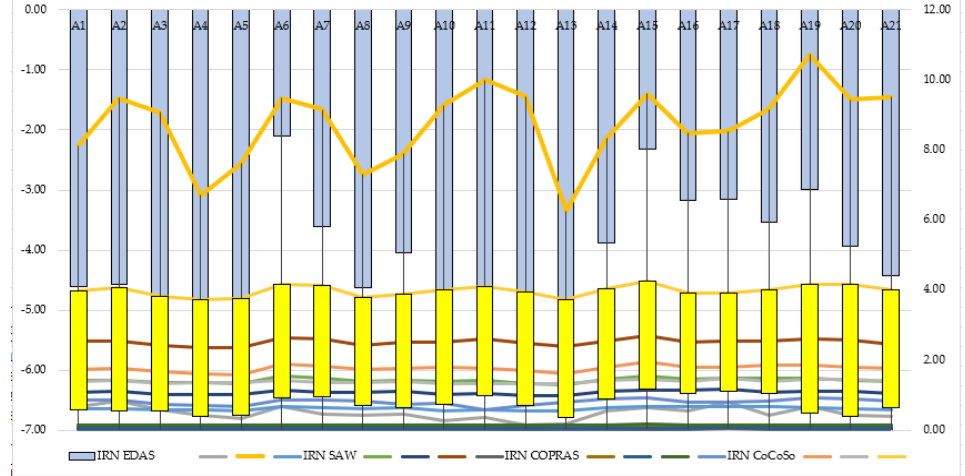
Figure 2. Values of alternatives through a comparative analysis.